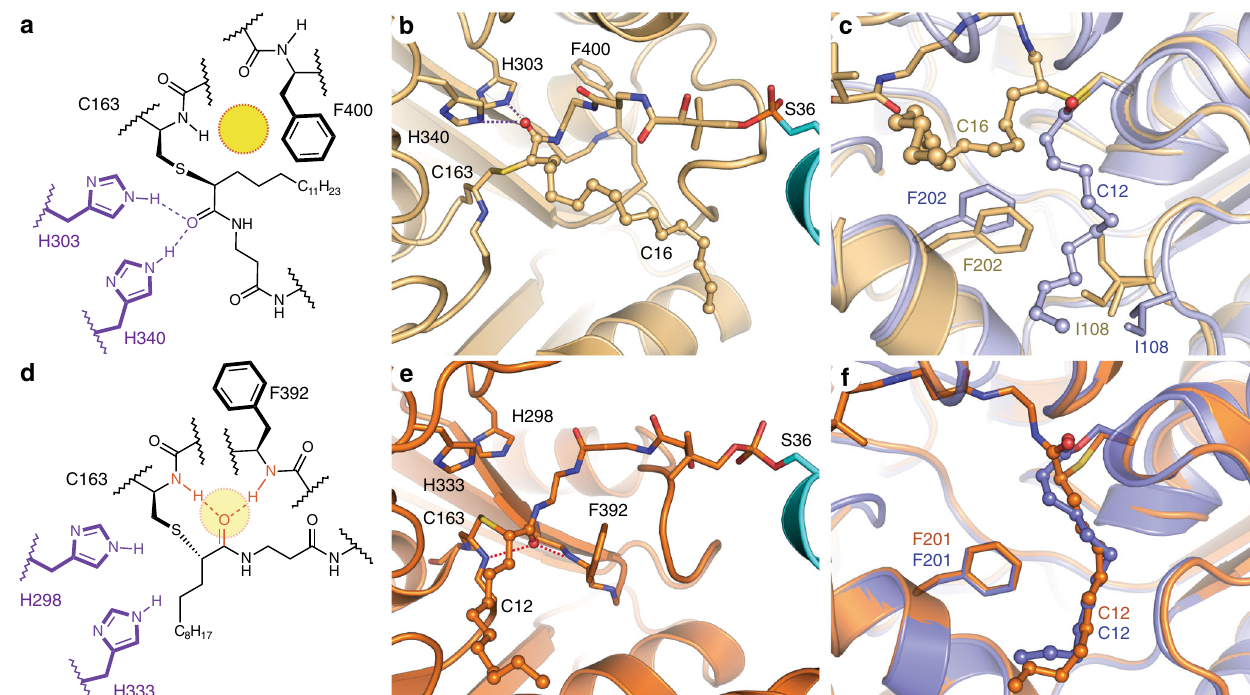
Fig. 4 FabF active site interactions with C16 substrate analog. a Schematic representation of the 4 ′ -phosphopantetheineamide crosslinker within the FabF active site. The disorganized oxyanion hole is shown as a yellow circle. b Active site interactions depicting the PPant crosslinker and C16 acyl chain from the crystal structure of C16AcpP – FabF. H340 and H303 coordinate the carbonyl of the acyl mimetic (blue dotted lines) and the active site oxyanion hole is disorganized. AcpP and FabF are colored cyan and light orange, respectively. c Comparison of acyl binding pocket and associated gating residues, F202 and I108, in dodecanoyl-FabF (12:0-FabF) (2GFY 43 , light purple), and C16AcpP – FabF (6OKG, light orange). d Schematic representation of the 4 ′ - phosphopantetheine crosslinker within the FabB active site. The organized oxyanion hole is shown as a transparent yellow circle with associated backbone amides and coordinated PPant carbonyl shown in red. e The carbonyl of the acyl mimetic in the crystal structure of C12AcpP – FabB is coordinated in the active site oxyanion hole formed by backbone amides of Cys163 and Phe392 (Phe400 in FabF). f Comparison of acyl binding pocket in dodecanoyl-FabB (12:0-FabB) (PDB ID: 1EK4 44 , bright purple), and C12AcpP – FabB (PDB ID: 6OKC, bright orange). Residues in panels are numbered according to their respective protein, FabF is numbered in FabF residue numbering and FabB is numbered in FabB residue numbering. Hydrogen-bonding interactions are represented as dotted lines, all side chain residues are represented as sticks, and the 4 ′ -phosphopantetheinyl arm is represented as sticks while the acyl chains are represented as ball and